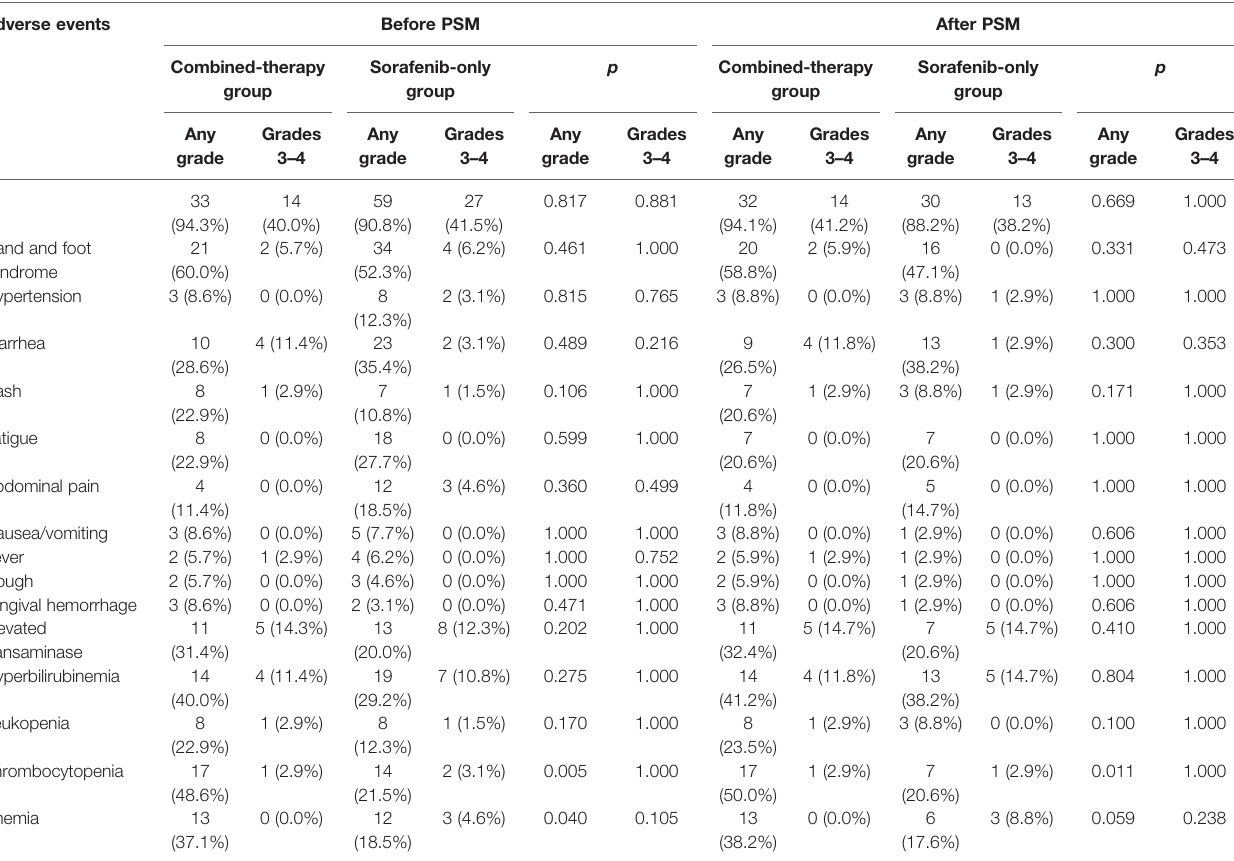
TABLE 3 | Treatment related adverse